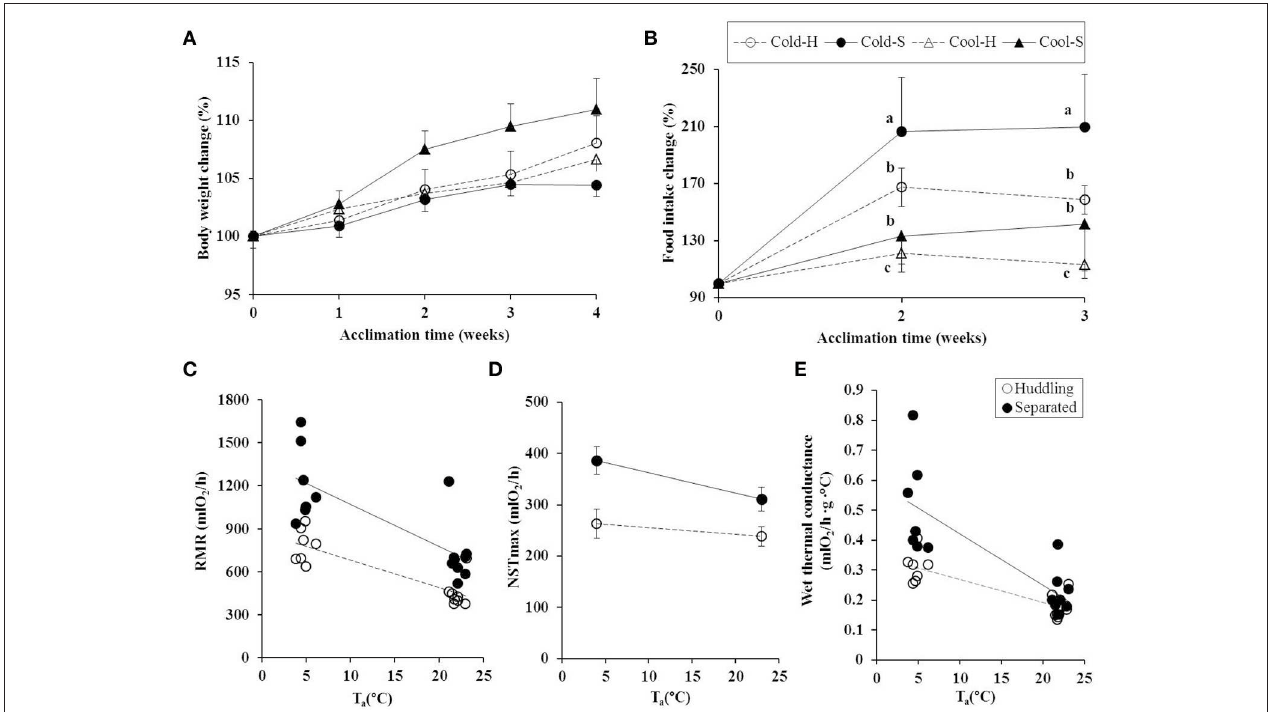
FIGURE 1 | Body mass changes (A) , group food intake (B) , group RMR (C) , NSTmax (D) , and group wet thermal conductance (E) in huddling and separated Brandt’s voles at cool and cold T a s. (A) : Cool-S, cool separated voles ( n = 32); Cool-H, cool huddling voles ( n = 28); Cold-S, cold separated voles ( n = 25) and Cold-H, cold huddling voles ( n = 27); (B) : Cool-S group ( n = 8); Cool-H group ( n = 7); Cold-S group ( n = 6) and Cold-H group ( n = 6); (C) : Cold-H group ( n = 7); Cold-S group ( n = 7); Cool-H group ( n = 8) and Cool-S group ( n = 9); (D) : Cold-H voles ( n = 7); Cold-S voles ( n = 7); Cool-H voles ( n = 8); Cool-S voles ( n = 9); (E) : Cold-H